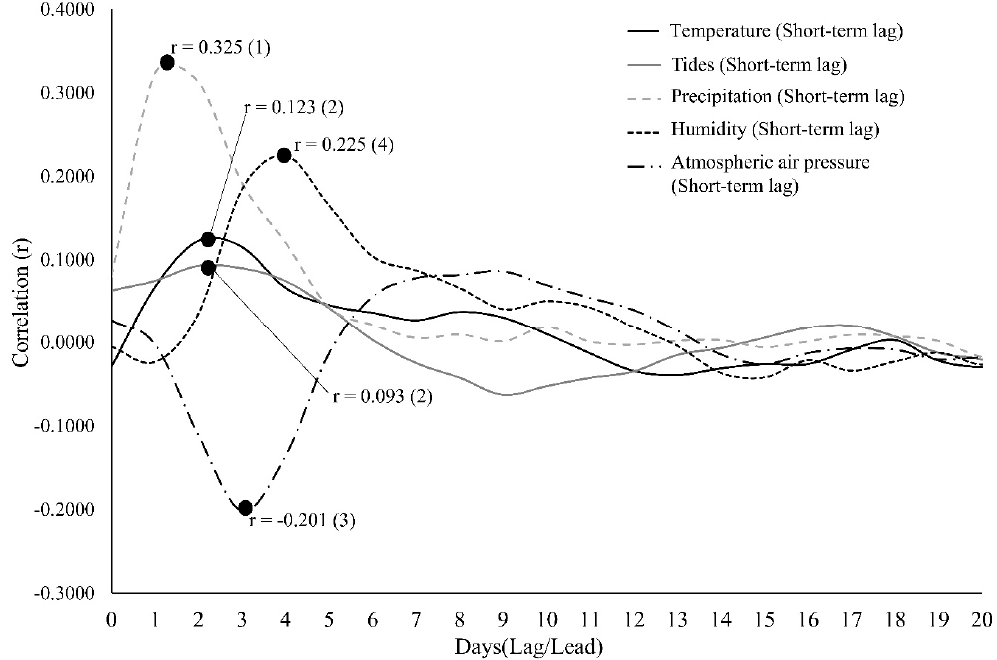
Figure 8. Determination of the strongest correlation between the water discharge and the predictor variables. The strongest correlation with is equal to − 1 or 1, while the weakest is equal to 0. The black dots represent the strongest correlation value.